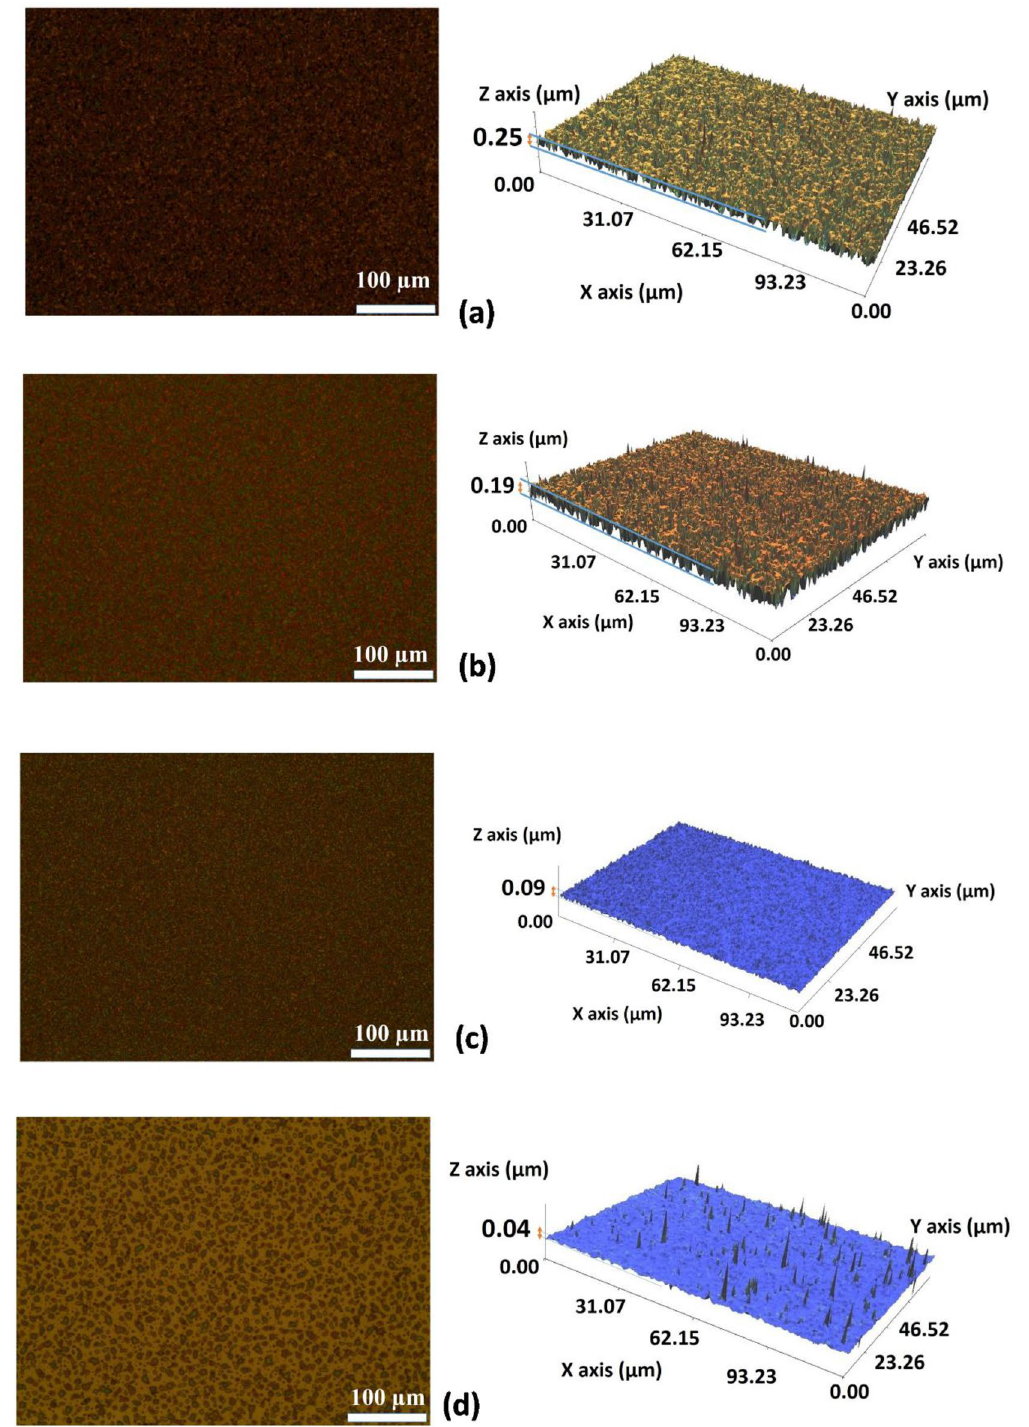
Figure 3. OM and 3D images of various electrosprayed QD thin films with ( a ) Solution A, ( b ) Solution B, ( c ) Solution C, and ( d ) Solution